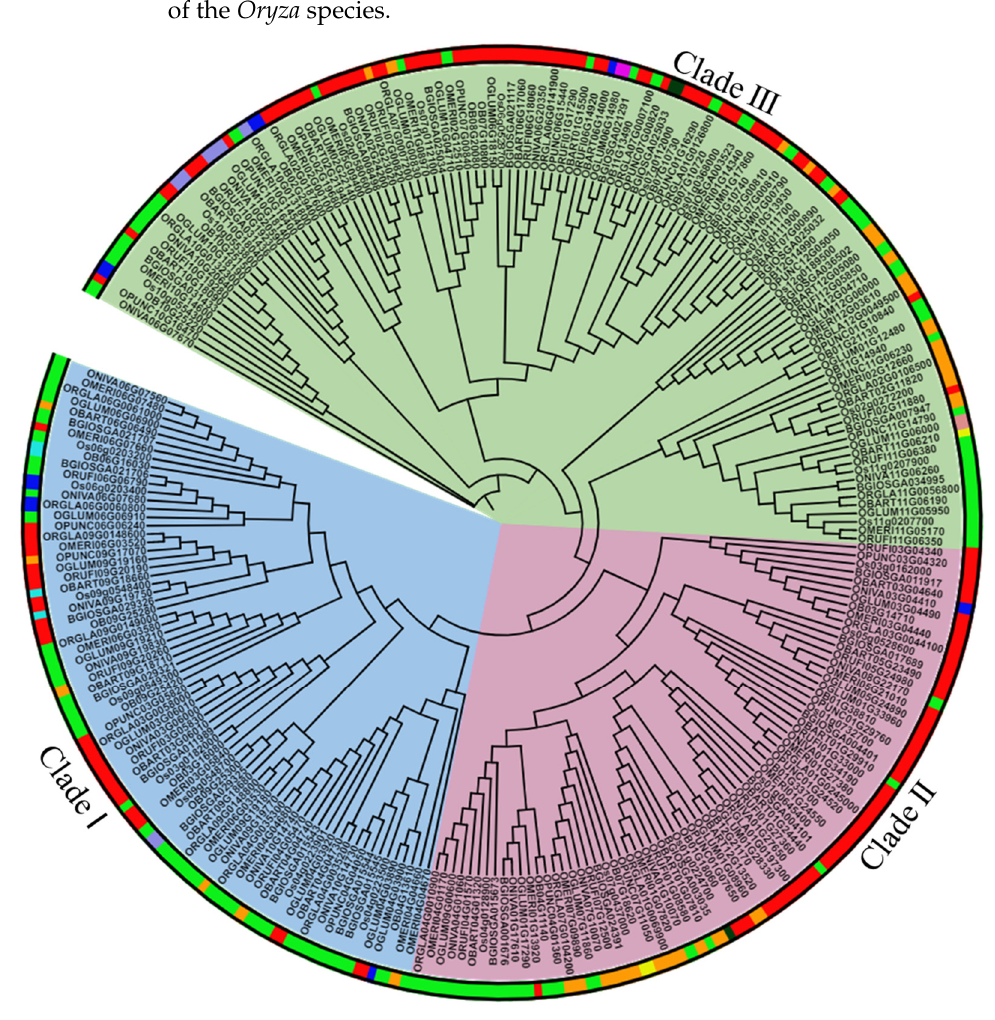
Figure 2. Evolutionary and sub-cellular localization analysis of FMO genes in wild and cultivated rice. A rooted circular phylogenetic tree, depicting evolutionary connection between the FMO encoding genes in wild and cultivated rice, was determined by maximum likelihood method with 1000 bootstrap replicates using MEGA 7.0 and visualised using iTOL. The subcellular localization of the genes has been indicated by a color strip around the tree. Red—cytoplasm, parrot green—chloroplast, dark green—endoplasmic reticulum, orange—plastid, blue—nucleus, cyan—vacuole, pink—golgi, peach—cytoskeleton, yellow—extracellular space. The branch lengths indicate the evolutionary time between the two nodes. Table 2. Distribution of FMO genes in 10 genomes of rice. The chromosome-wise distribution of the identified FMO family members in the genomes of ten Oryza species, arranged according to their evolutionary history. O. brachyantha is the most distant and O. sativa subp. japonica is the most recent among these species. Each row contains list of genes that are orthologs of each other in different Oryza species. The blank space denotes the absence of the corresponding ortholog in the respective